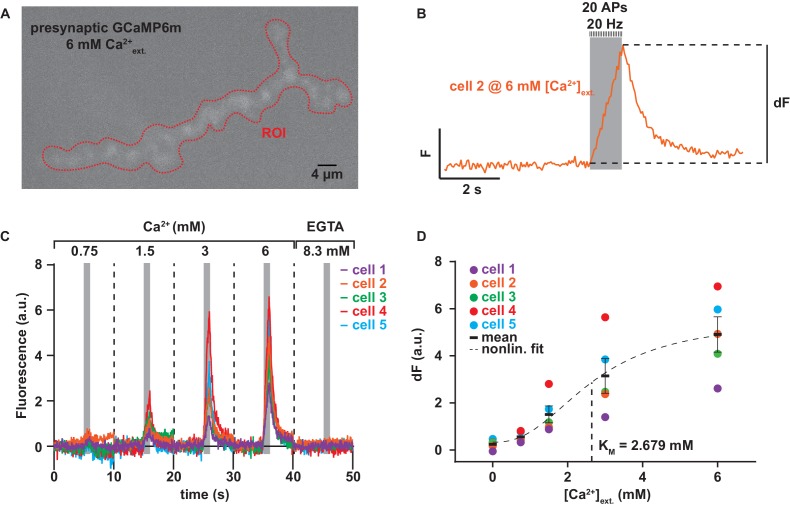
Experiment to determine the dependence of AP-induced Ca2+ influx on the extracellular Ca2+ concentration.(A) Example frame of maximum fluorescence during recording of presynaptic GCaMP6m at 6 mM extracellular Ca2+. Red dotted line indicates the ROI used for read-out of the fluorescence signal. (B) 10 s fluorescence trace of experiment shown in A. At the 5 s mark, 20 APs are given over 1 s. Subtracting the fluorescence at 4.75 s from the maximum fluorescence gives the value dF plotted in panel D. (C) Baseline-subtracted fluorescence (see Materials and methods for details) traces of 5 different animals over the whole range of extracellular Ca2+ concentrations. 8.3 mM EGTA was added at the end to quench Ca2+ influx. (D) Quantification of dF (see panel B) per cell and Ca2+ concentration. The nonlinear fit with hill coefficient, m, of 2.43 (as previously determined for GCaMP6m Barnett et al., 2017) is indicated as a dashed black line, see Materials and methods for details. Mean is shown as black bars ± SEM. Used genotype: w[1118]; P{y[+t7.7] w[+mC]=20XUAS-IVS-GCaMP6m}attP40 crossed to Ok6-GAL4. Materials and methods section ‘Fly husbandry, genotypes and handling’ lists all exact genotypes. Data summary as well as best fit Hill curve corresponding to the depicted graph can be found in the accompanying source data file (Figure 3—source data 1).